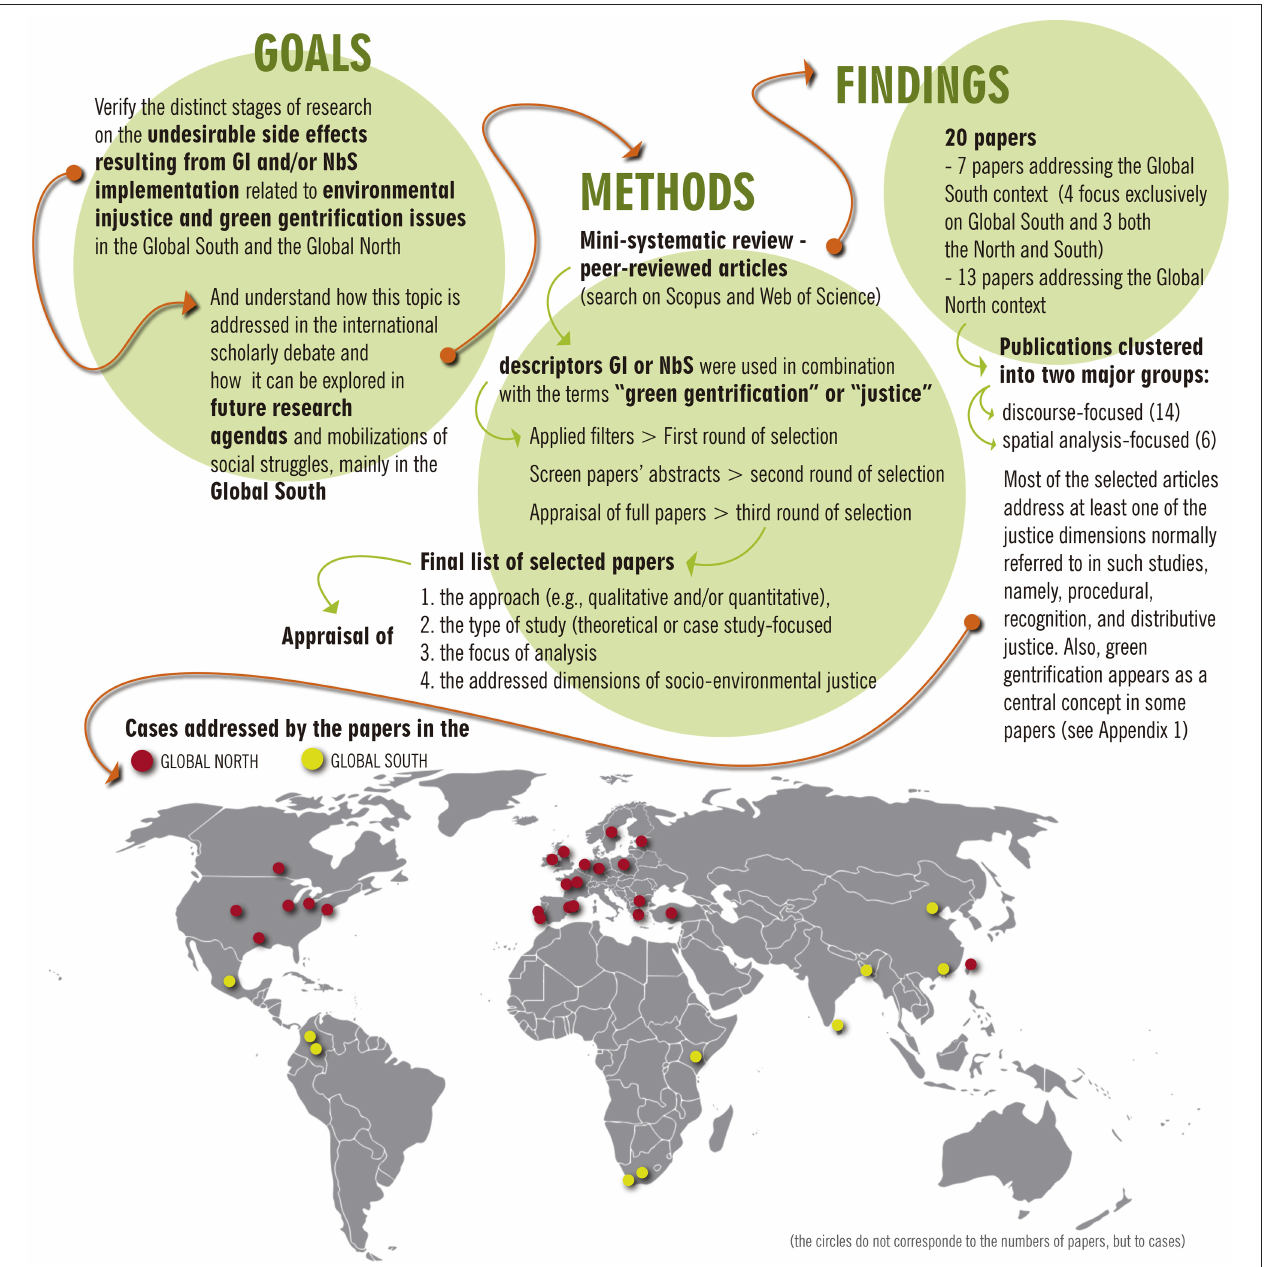
FIGURE 1 | Synthesis of the methodological steps and main findings of the paper.